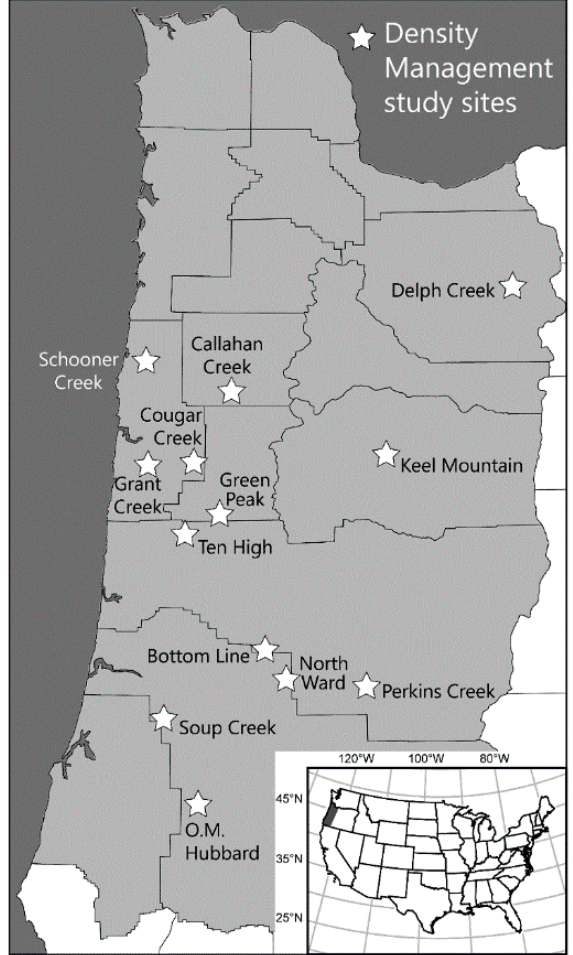
Figure 1. Locations of 13 sites for the Density Management Study in Western Oregon, USA, analyzed with regard to spatial and temporal variation in headwater streamflows.